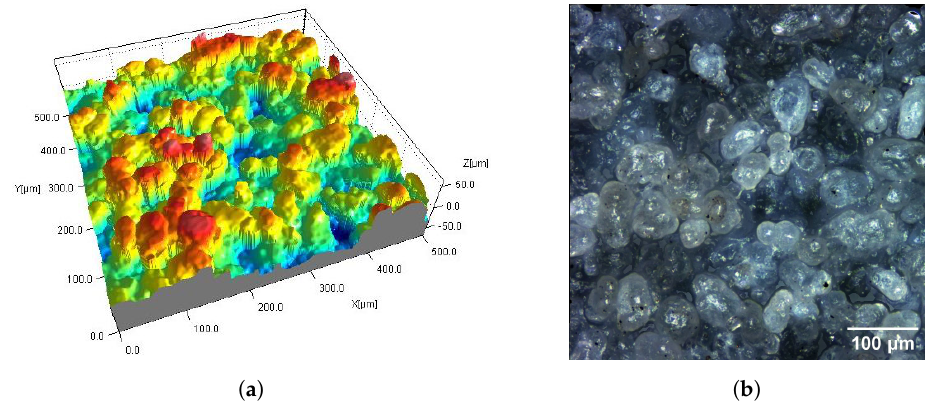
Figure 2. Surface of SLS sample without post-processing (Ref): fragment 0.5 mm × 0.5 mm of 3D map ( a ) and corresponding 2D view ( b ).